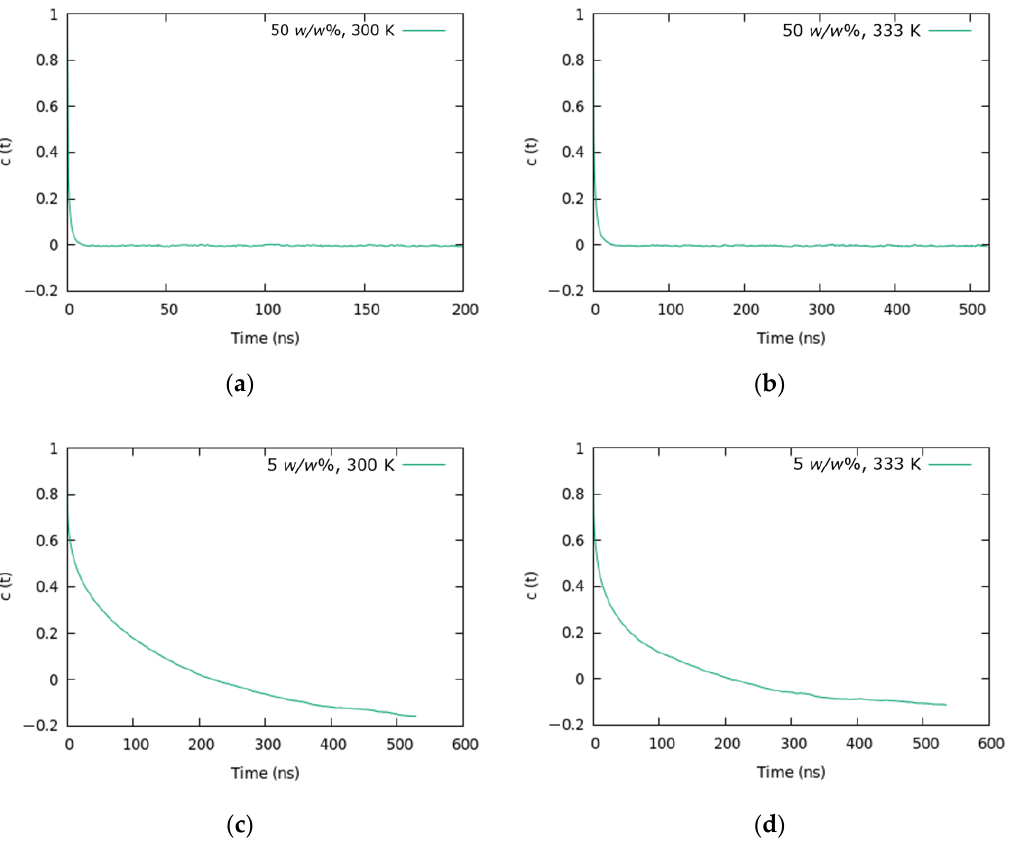
Table 3. Relaxation time ( 𝜏 𝑃𝑆 ) computed for systems at 50 and 5 w/w% toluene. Standard errors were calculated by dividing the 150 aPS chains into 10 groups.